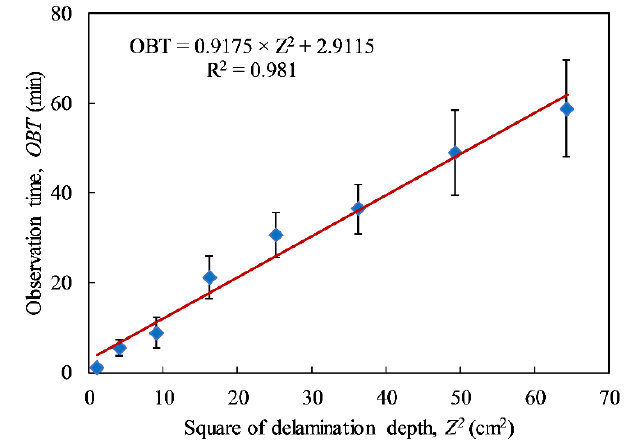
Figure 10. Relationship between the observation time under all cases of heating times and square of delamination depth.